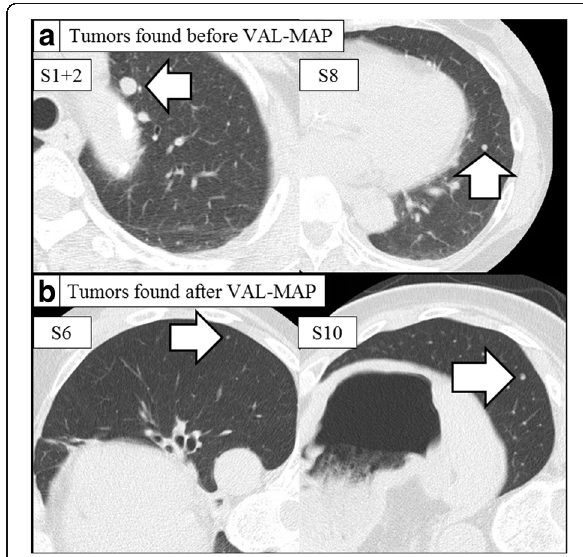
Fig. 1 Chest computed tomography images of pulmonary nodules.